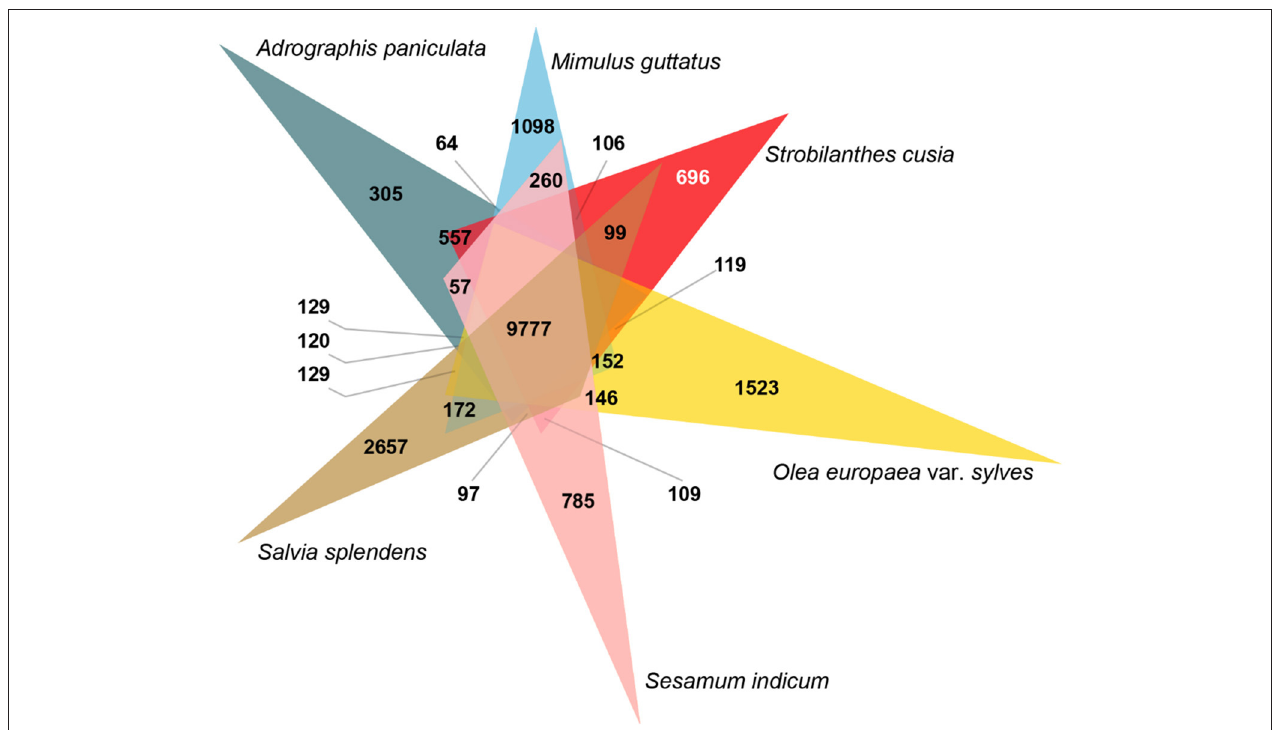
FIGURE 2 | Analysis of Venn diagram of orthologous gene families. Six species ( S. cusia , Mimulus guttatus , Andrographis paniculata , Salvia splendens , Sesamum indicum , and Olea europaea var. sylvestris ) were exploited to generate the Venn diagram based on the gene family cluster analysis. The white number 696 in parentheses represents the gene family specific to S. cusia in all six plants